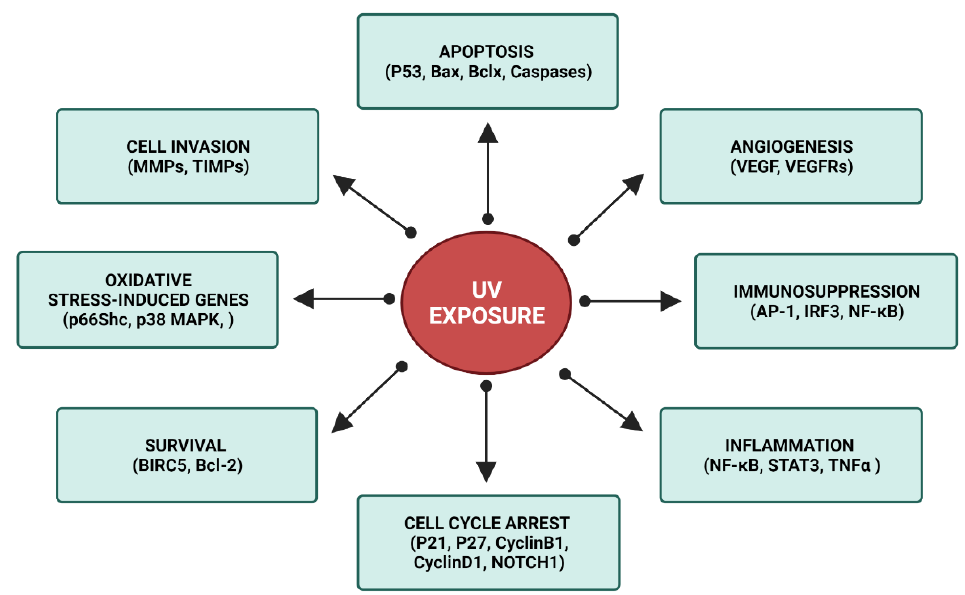
Figure 3. Schematic representation of the intracellular pathways triggered by UV exposure (created with BioRender.com (accessed on 10 September 2021)).